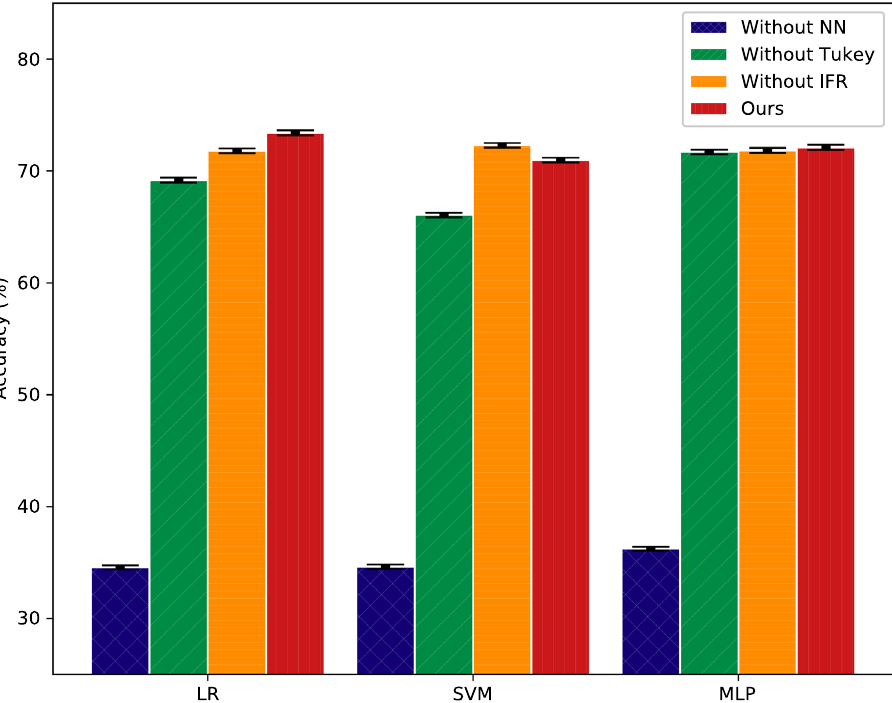
Figure 4. Experimental results of different modules used in IFR based feature augmentation method on 5-way 1-shot task of miniImageNet dataset. The X-axis coordinate represents three classification models, and the Y-axis represents the accuracy of each model. “Without NN” represents that the nearest neighbor prototypes matching module is instead by random select. “Without Tukey” represents that the Tukey’s ladder of powers transformation module is not used in IFR based feature augmentation method. “Without IFR” represents that only query feature vectors set QueryTopK is used in feature augmentation.